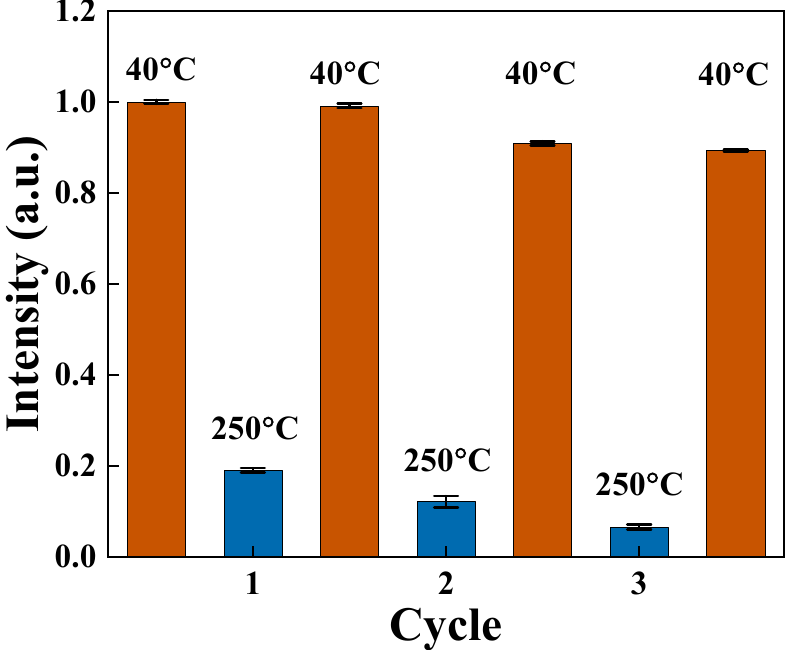
Figure 4. The relationship between fluorescence intensity at 616 nm of Zn-CYMPN ⊃ DPEE-1 and temperature during three thermocycles in the range of 40~250 ◦ temperature during three thermocycles in the range of 40~250 °C.